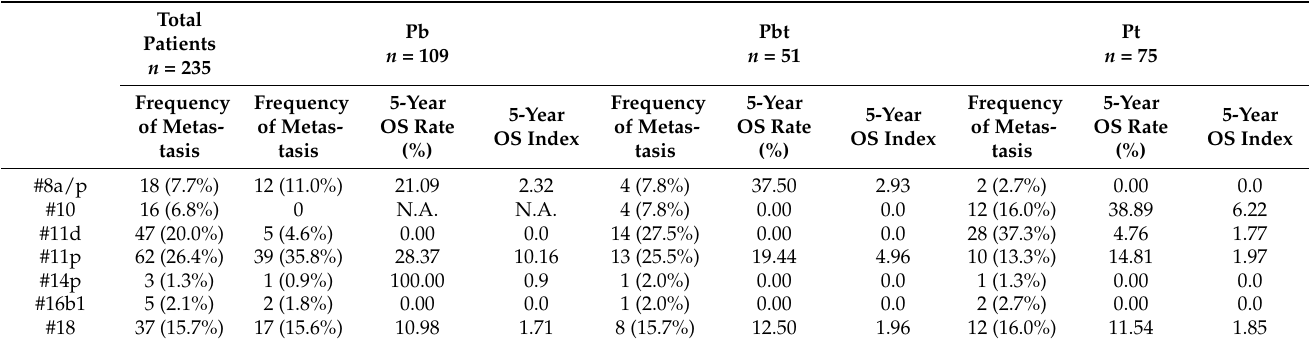
Table 2. Distribution of lymph node metastasis based on tumor site and efficacy index according to the 5-year survival rate.